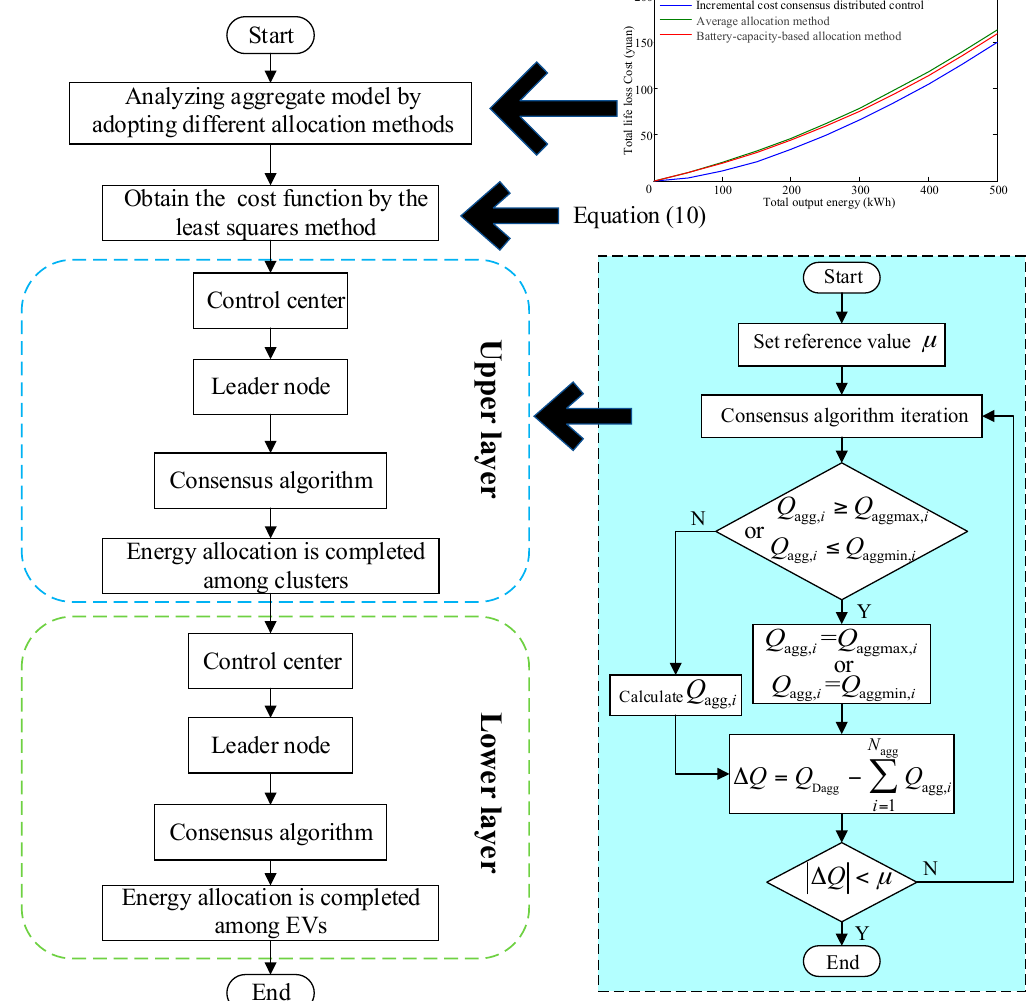
Figure 3. Flowchart of the hierarchical distributed control strategy.